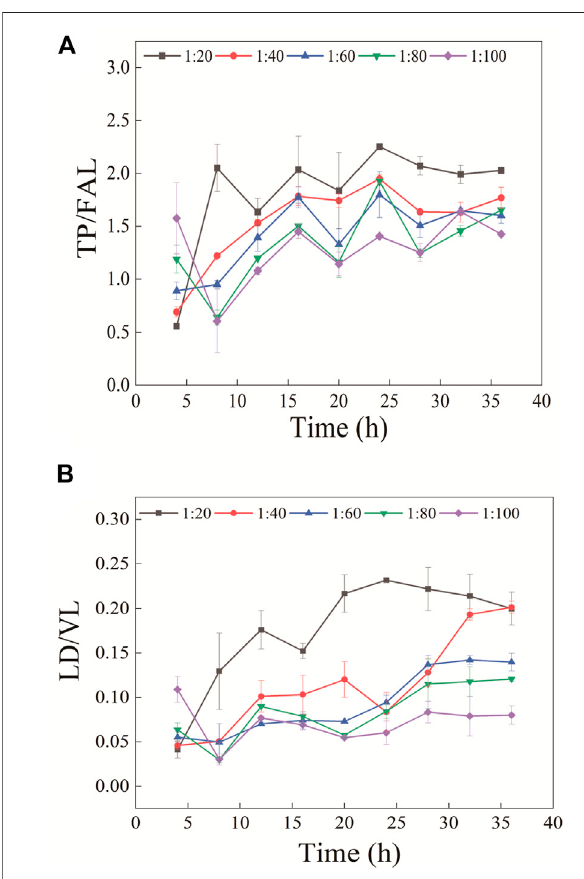
FIGURE 4 | Ratio of peptides (A) TP/FAL and (B) LD/VL changes with enzyme concentration and enzymatic hydrolysis time ( n = 3).